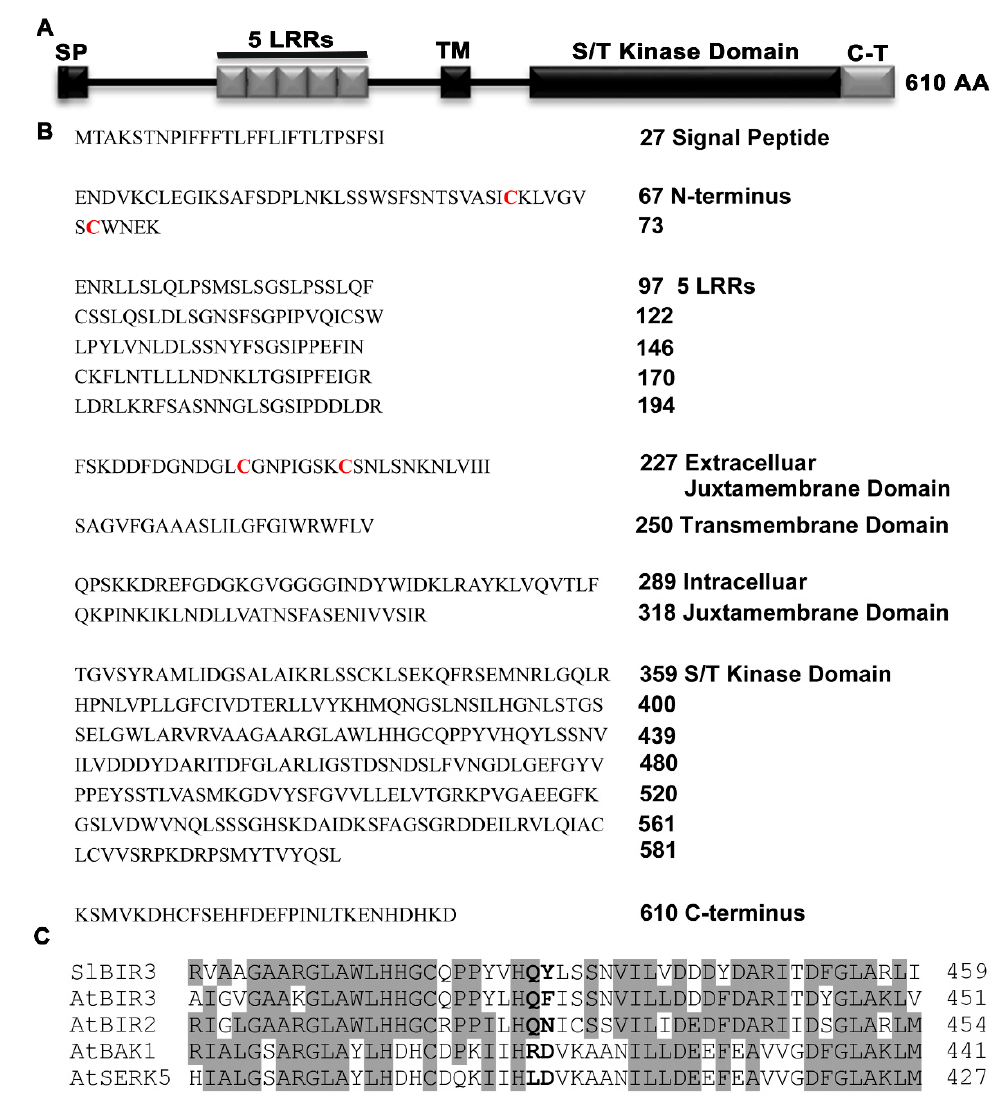
Figure 1. SlBIR3 encodes a leucine rich repeat (LRR) receptor-like protein kinase. ( A ) Domain structure of SlBIR3 . SP, signal peptide: LRR, leucine-rich repeat; TM, transmembrane domain; S/T kinase